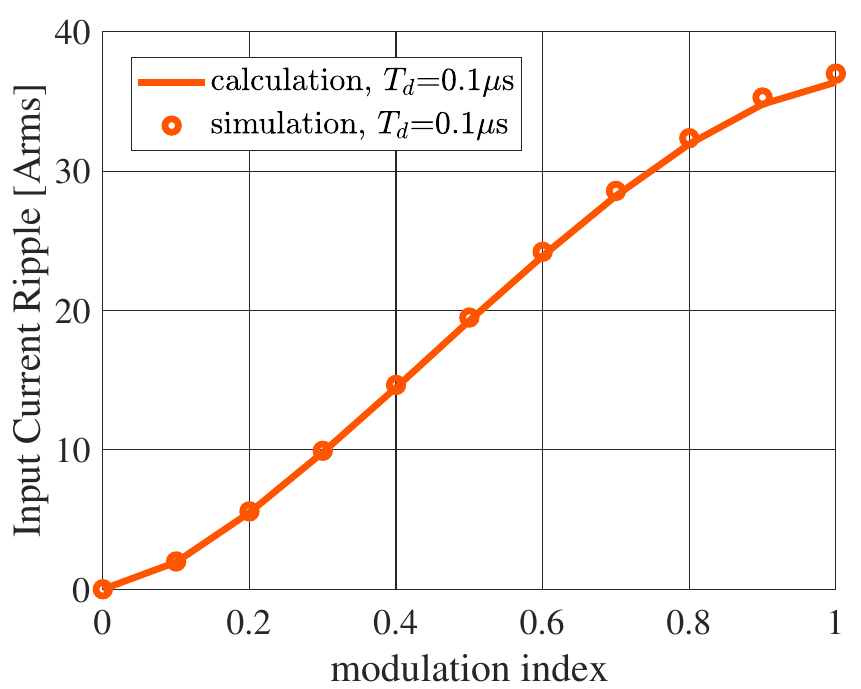
Figure 8. Calculation and simulation results of modulation index vs. rms input current ripple of the three-phase VSI (case 2 load, T d = 0.1 µ s).